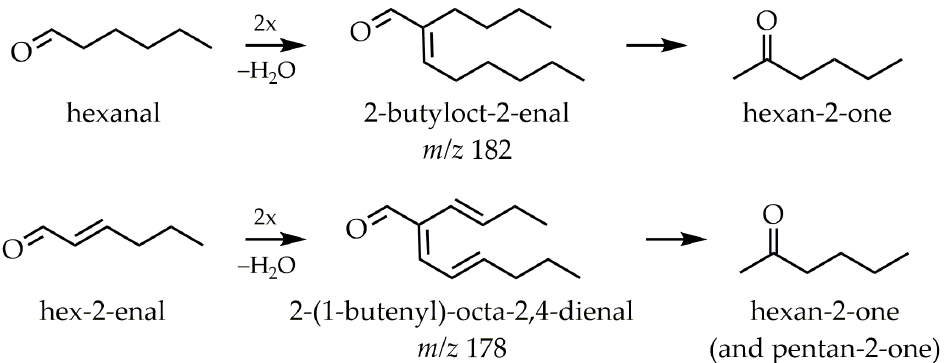
with the highest intensities of both aldol condensation products differed by 4 Da each, due to the two additional double bonds of the 2-(1-butenyl)-octa-2,4-dienal. However, 2-(1-butenyl)-octa-2,4-dienal has not been mentioned as an aldol condensation product of hex-2-enal in the literature before.